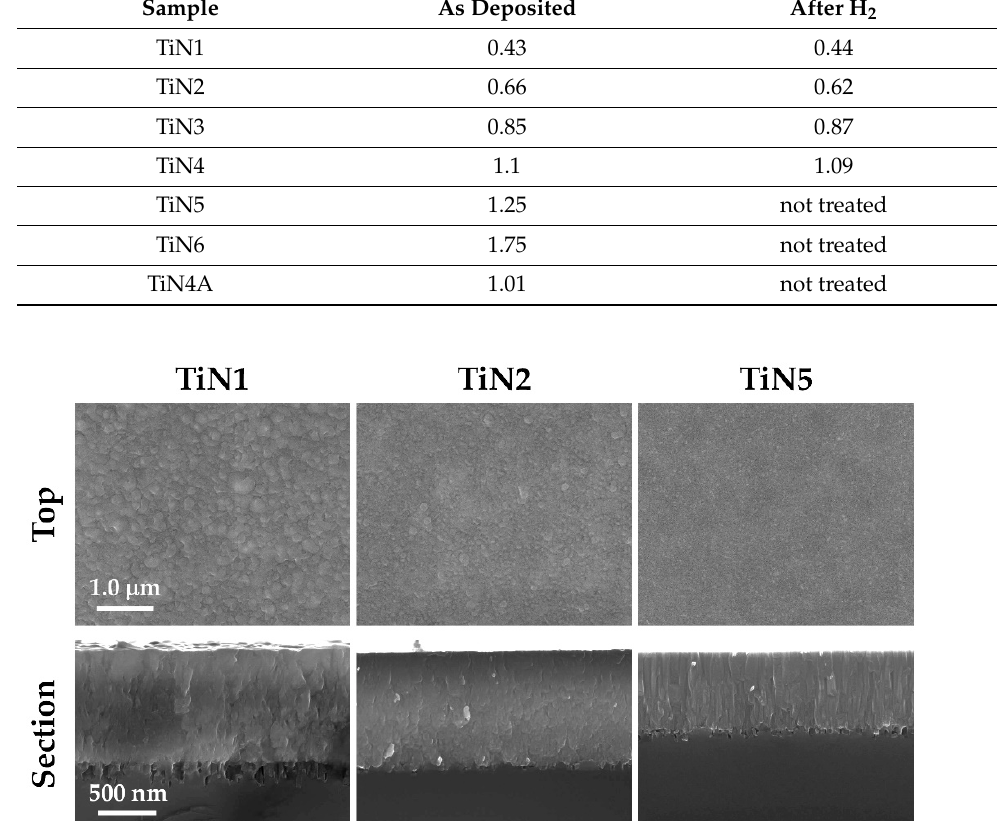
Figure 2. SEM top views and sections of samples TiN1, TiN2, and TiN5 as the deposition tempera- ture and the percentage of reactive process gas